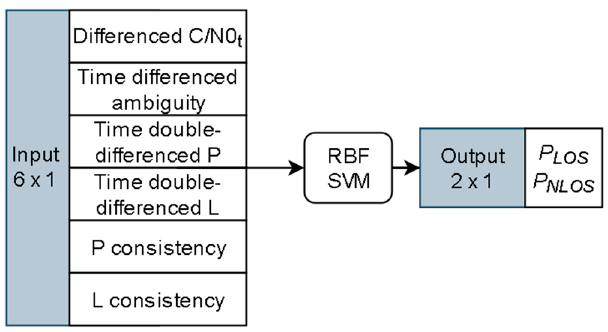
Figure 1. Structure of SVM signal classifier.